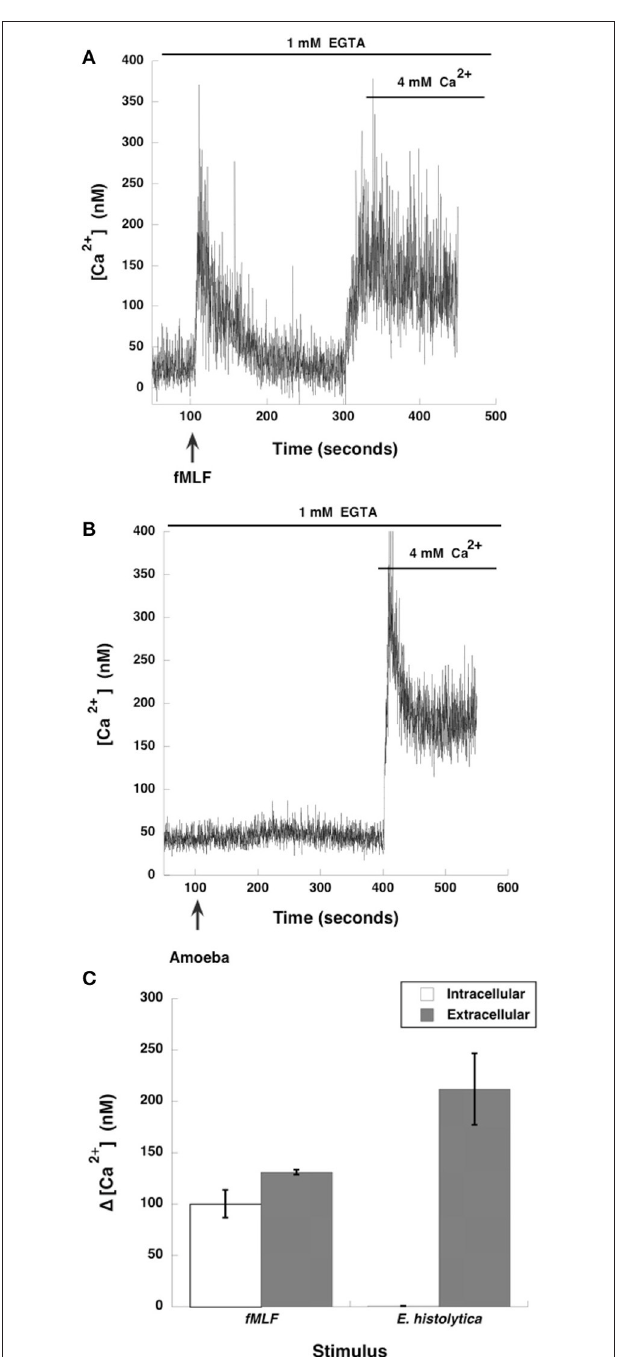
FIGURE 5 | Entamoeba histolytica trigger extracellular calcium mobilization in neutrophils. Human neutrophils were incubated with fura-2 for 30min and then placed in PBS with EGTA. Neutrophils were stimulated (arrow) with (A) 10nM formyl-methionyl-leucyl-phenylalanine (fMLF), or were stimulated with (B) E. histolytica trophozoites (amoeba). After about 250s, an excess (4mM) Ca 2 + was added to the buffer. Changes in cytosolic calcium concentration were assessed by measuring the variations in fluorescence of fura-2-loaded cells. Tracings are representative of three experiments. (C) The increase of cytosolic calcium concentration ( 1 [Ca 2 + ]) is shown from intracellular or extracellular calcium pools. Data are mean ± SEM of three